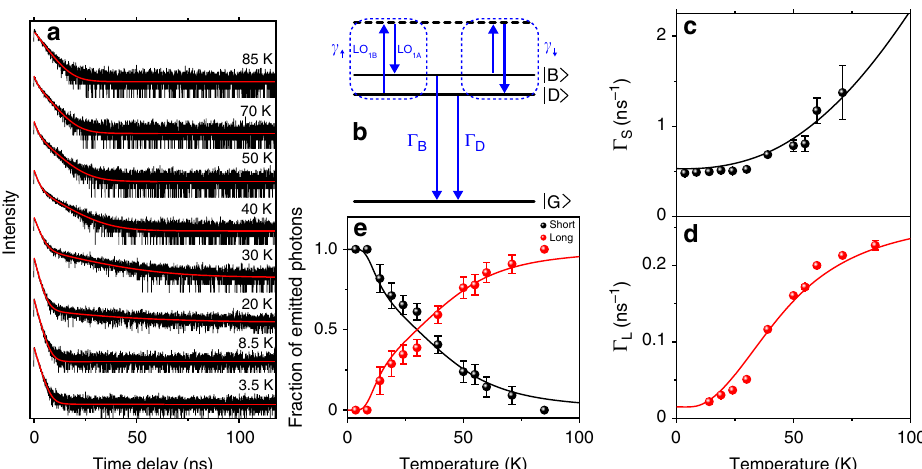
Fig. 4 Evolution of the PL decay of a single FAPbI 3 NC with temperature. a PL decays of the same FAPbI 3 NC at various temperatures, under pulsed excitation at 488 nm with an average intensity of 30 W cm − 2 . A log-log scale representation is displayed in Supplementary Fig. 12. b The three-states model. G j i is the zero-exciton state, D j i and B j i are the lowest dark and bright excitons with recombination rates Γ D and Γ B , respectively. ∣ D ⟩ and ∣ B ⟩ are thermally mixed with a two-LO-phonon process with rates γ ↑ and γ ↓ . c Temperature dependence of the fast decay rate Γ S and d of the slow decay rate Γ L . The plain curves are simulations with the two-phonon thermal mixing model, taking Γ B = 0.53 ns − 1 , Γ D = 0.015 ns − 1 , γ 0 = 0.16 ns − 1 , E LO1A = 3.3 meV, E LO1B = 3.6 meV. e Temperature dependence of the fractions of emitted photons with fast and slow decay rates. The solid lines are derived from the three-level model with the same set of parameters. The error bars displayed in c , d and e represent the fi tting errors of the parameters deduced from and two excitonic levels D j i and B j i representing, respectively, the dark and the bright excitons, with recombination rates Γ Γ D (essentially nonradiative) and B (mainly radiative). Thermal